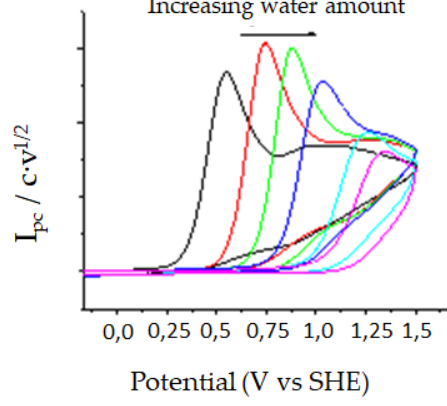
Figure 4. Cyclic voltammetry of 5 mM TBA 2 C 2 O 4 with glassy carbon under N 2 atmosphere. Scan rate: 0.5 V·s −1 . Table 2. Catalytic parameters in homogeneous catalysis of CO 2.